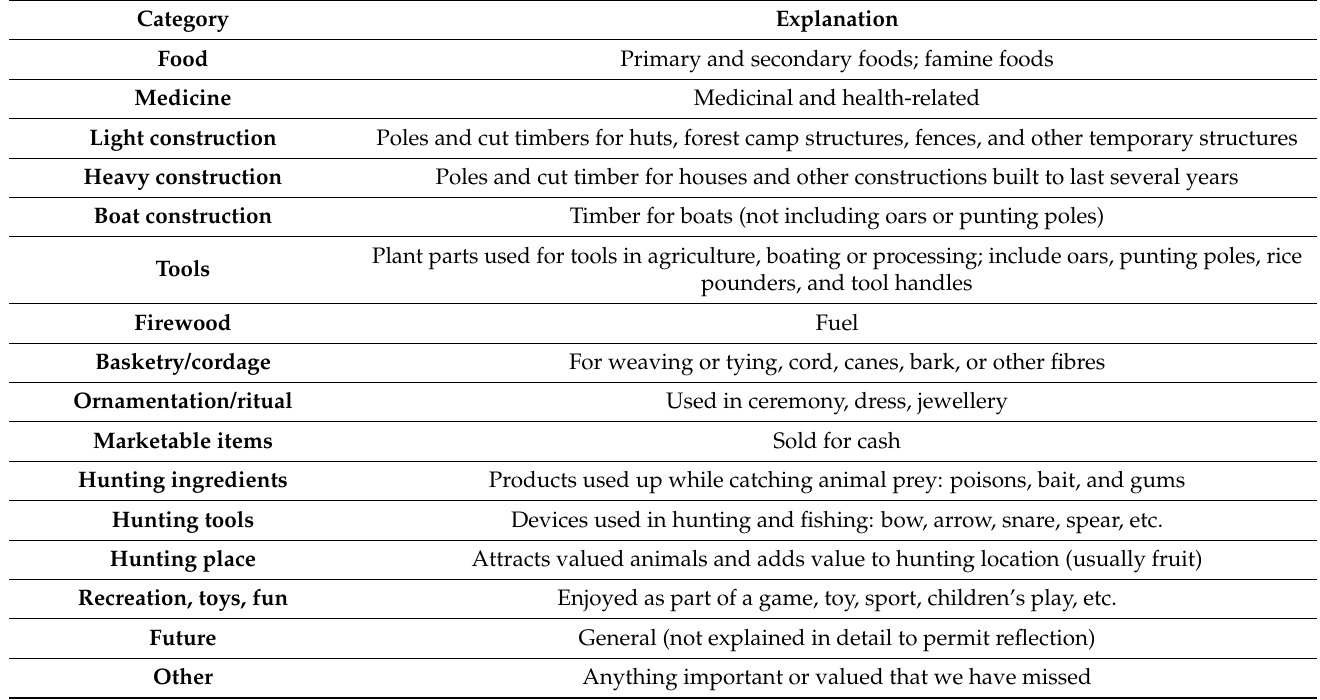
Table 1. Categories and explanations used to summarise plant uses and